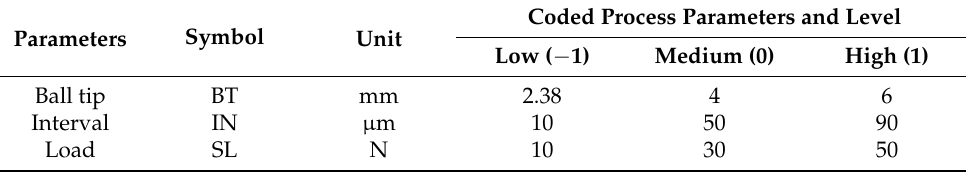
Table 2. Coded process parameters and their levels.